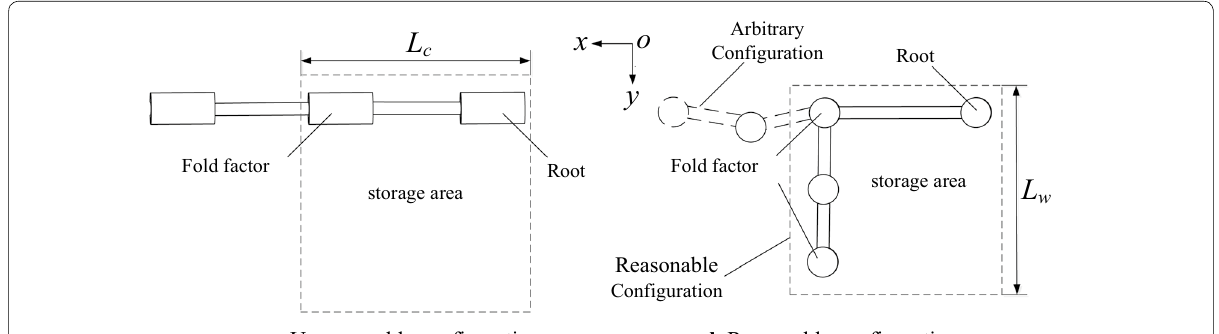
Figure 6 Configuration method under the restriction of storage